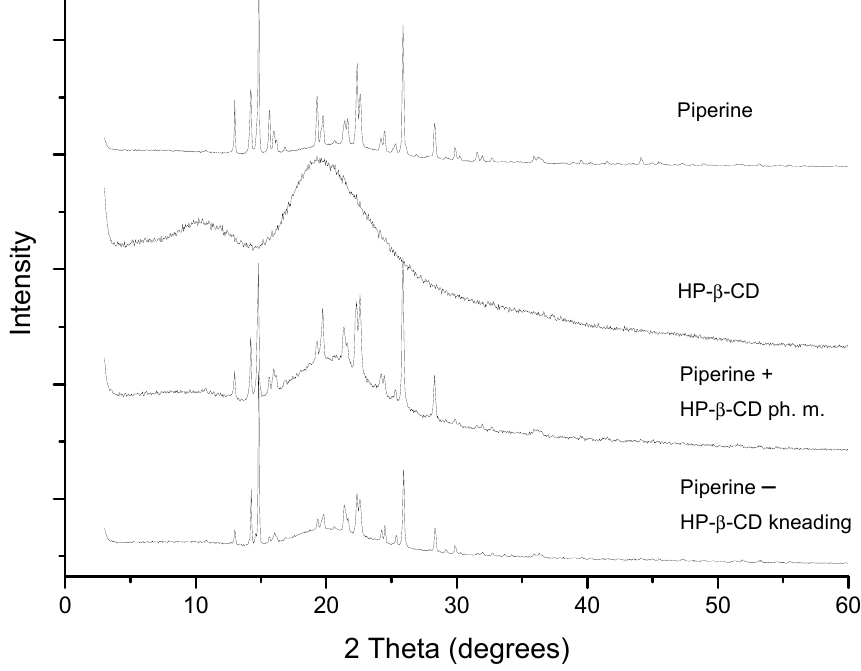
Figure 3. X-ray powder diffraction (XRPD) diffraction patterns of piperine, the mixture with HP- β - CD obtained by kneading method and physical mixture.